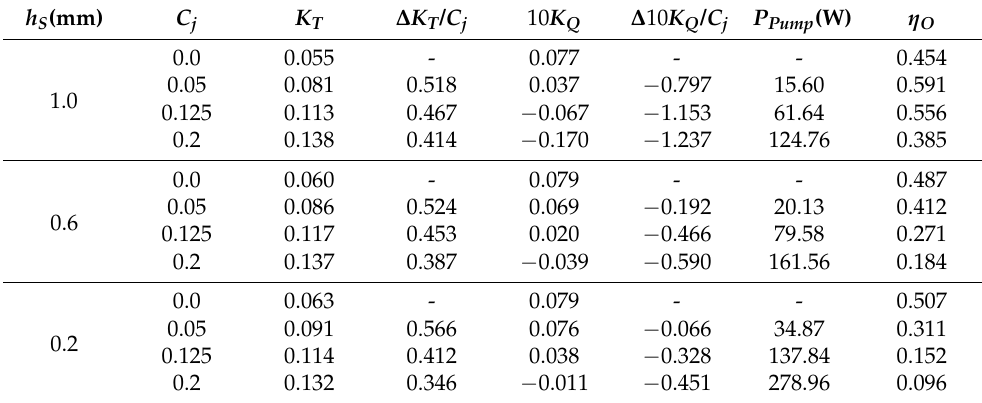
Table 6. The comparison of propeller performance change according to C j at each slit